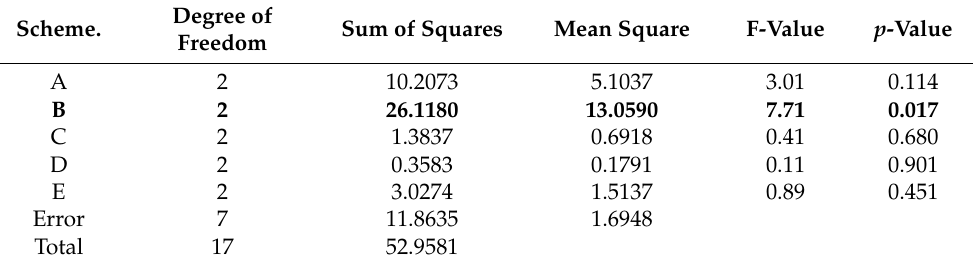
Table 9. Analysis of variance for S/N ratios of grey relational grade (GRG) during the floccula- tion of the Bacillus sp. BioSol021 cultivation broth and antimicrobial activity testing against the selected